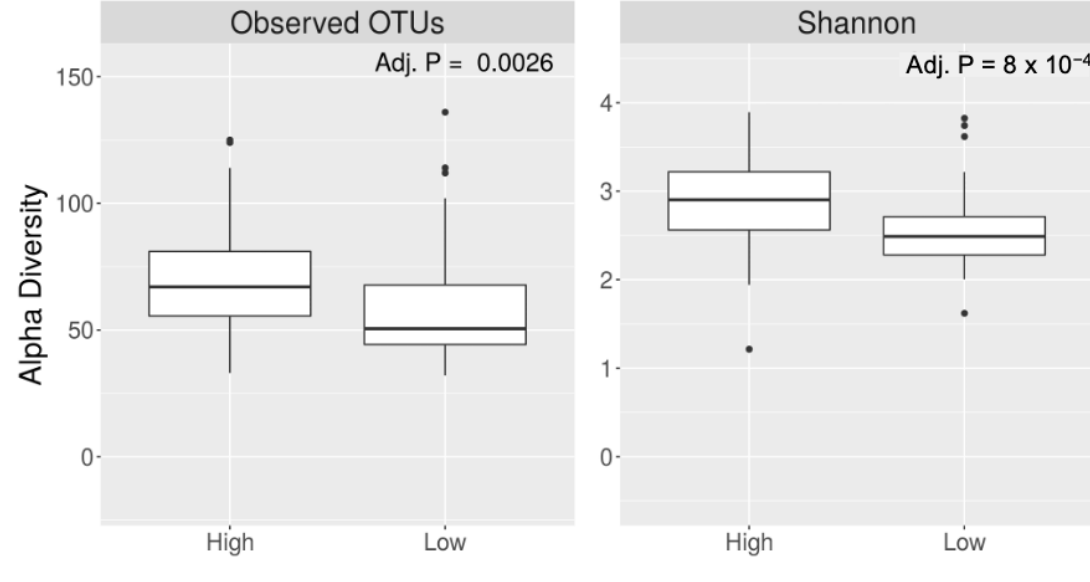
Figure 2. Alpha diversity of gut microbiota based on higher vs. lower caffeine intake.